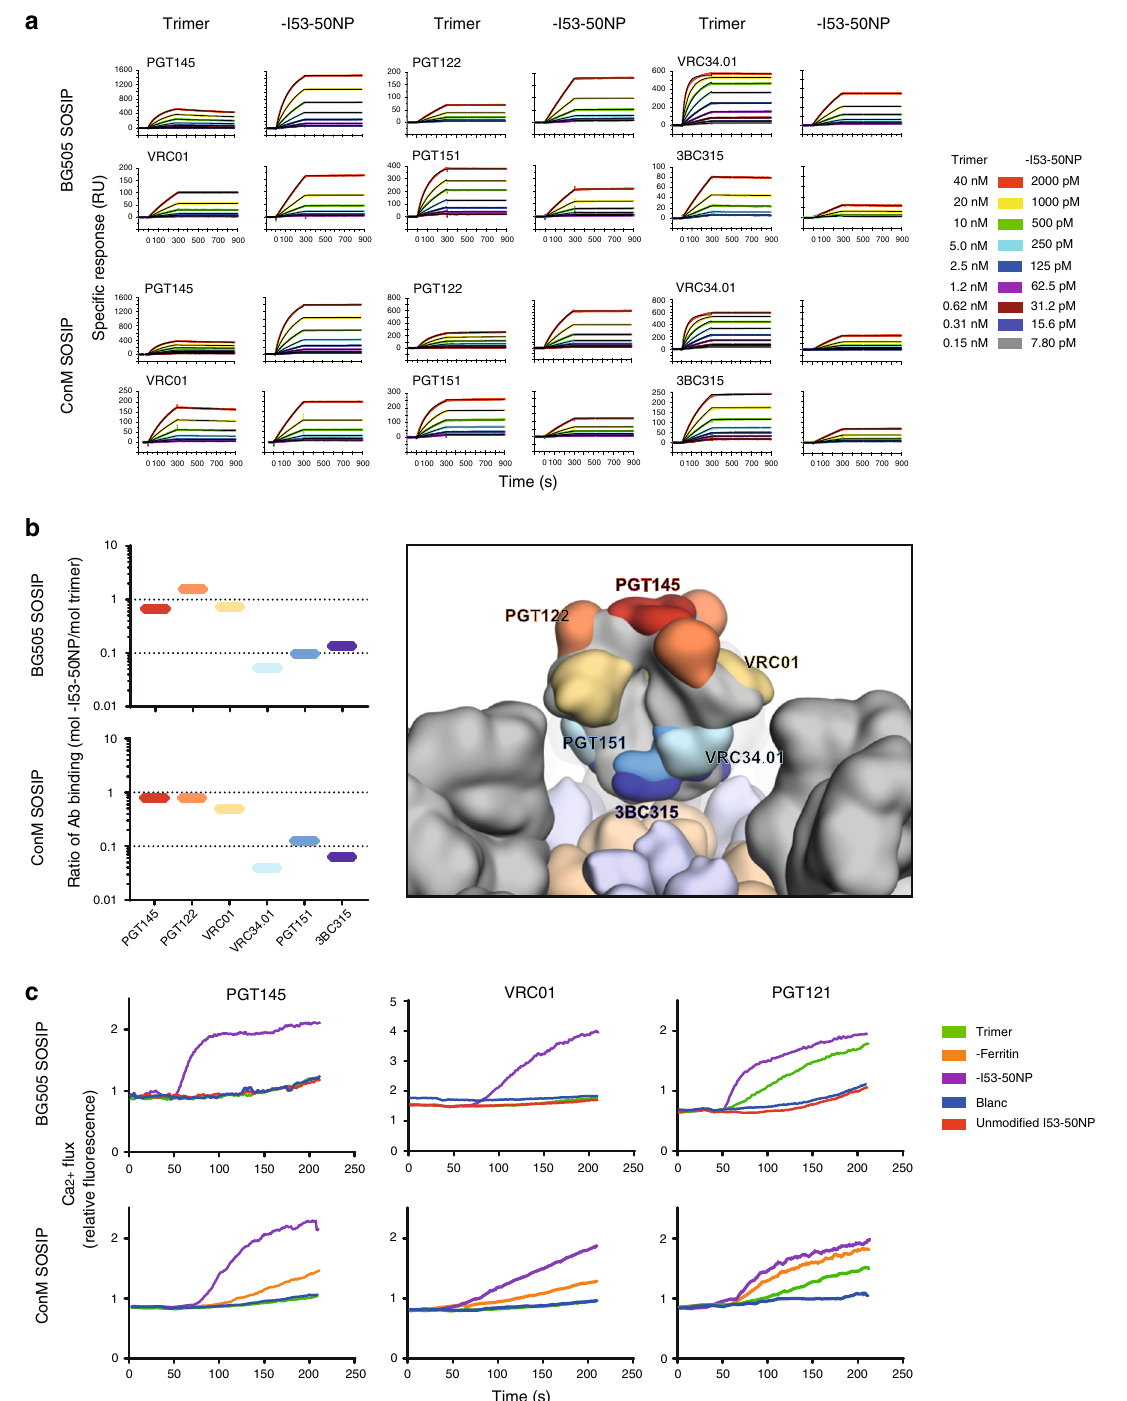
Fig. 4 SPR and B-cell activation analysis of BG505 and ConM SOSIP-I53-50NP. a Each pair of sensorgrams shows the binding of SOSIP trimer (left) and SOSIP-I53-50NPs (right) to immobilized IgG of the bNAbs indicated above the sensorgrams. Trimers and NPs were titrated at a constant ratio of concentrations corresponding to equal amounts of SOSIP per volume as indicated in the color code to the right. Langmuir model fi ts in black are overlaid on the colored binding curves for each concentration. Please note that although Langmuir curves were fi tted, no kinetic modeling was performed due to severe mass-transport limitations (for further explanation, see SOSIP trimer and SOSIP-I53-50NP binding to immobilized mAbs by SPR in Supplementary Methods). b The difference in macromolecules of SOSIP trimer or SOSIP-I53-50NP bound to several immobilized bNAbs plotted as a ratio (left) and a model of SOSIP (gray) presented on the I53-50NP (I53-50A in beige, I53-50B.4PT1 in light blue) with the corresponding bNAb footprints shown. c Activation of PGT145, VRC01, and PGT121-expressing B cells, measured by Ca 2 + fl ux over 210 seconds for BG505 and ConM SOSIP-I53-50NPs (purple), ConM SOSIP-ferritin (orange), and the corresponding trimer (green). Unmodi fi ed I53-50NPs (red) were included to determine nonspeci fi c activation by the I53-50NP core. Blanc, for which PBS was used, functioned as an additional negative control (blue). Source data are provided as a Source Data fi